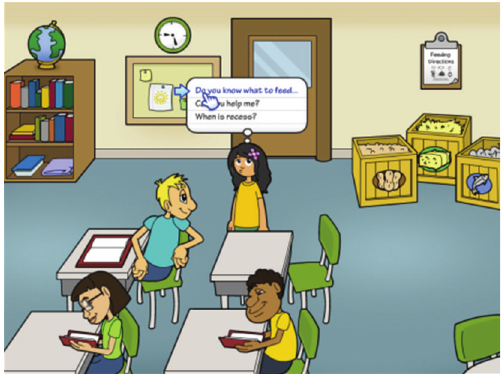
Figure 1: Dialogue selection